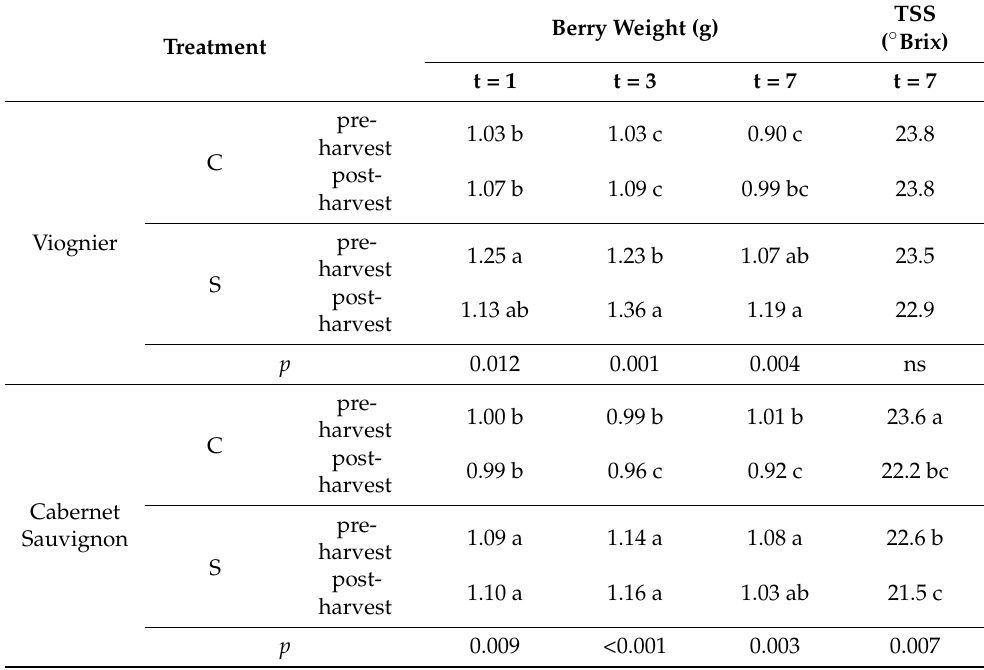
Table 1. Berry weight and total soluble solids (TSS) of control (C) and smoke-exposed (S) grapes.